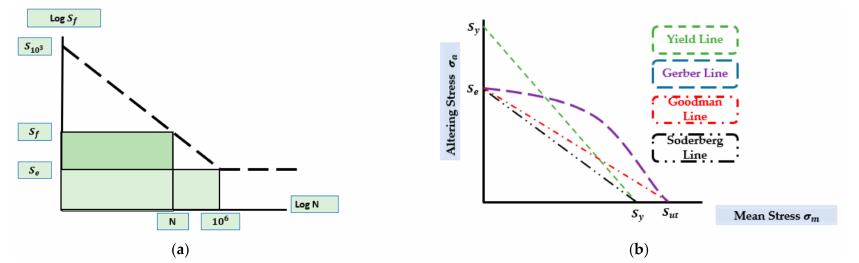
Figure 10. ( a ) S-N diagram following industry standards for high-cycle loading, ( b ) graphical representation of fatigue estimation models of non-fully reversed loading